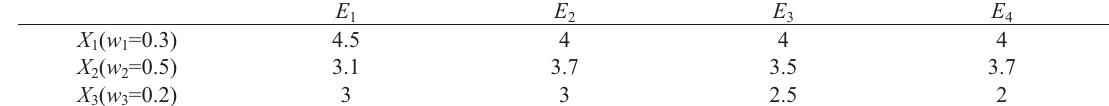
Table 9. The integrated decision matrix